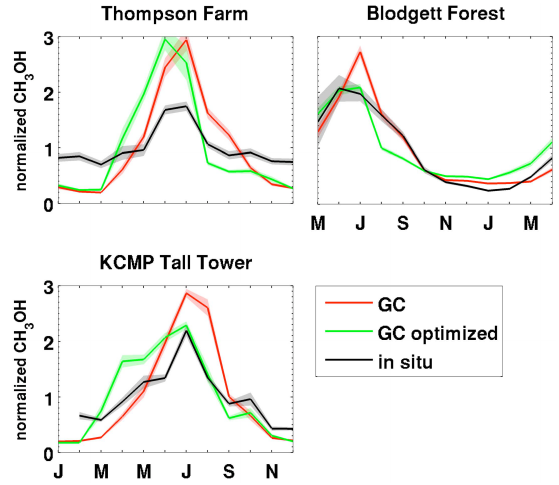
Fig. 10. Seasonal cycle in atmospheric methanol at North Amer- ican surface sites. Observations from Thompson Farm in NH, USA (January–December 2008), Blodgett Forest in CA, USA (May 2000–April 2001), and the KCMP tall tower in MN, USA (January– December 2010), are compared to modeled concentrations from the GEOS-Chem base-case (red) and optimized (green) simulations. Concentrations are normalized to the annual mean in each case. Model results for Blodgett Forest are for 2009 rather than 2000– 2001. Lines show the monthly mean values, while shaded areas in- dicate the standard error about the